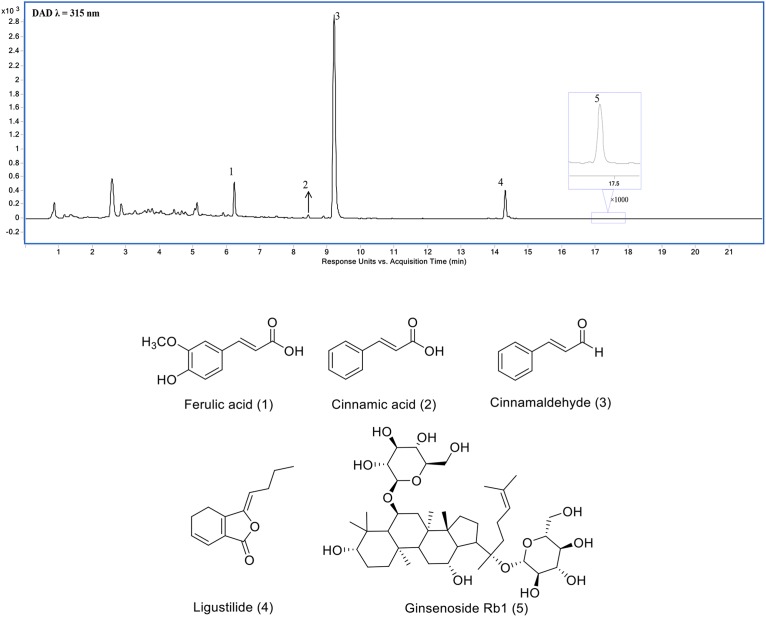
Ultra-high performance liquid chromatography (UHPLC) chromatogram of SSS extraction (1) ferulic acid, (2) cinnamic acid, (3) cinnamaldehyde, (4) Ligustilide, and (5) ginsenoside Rb1.